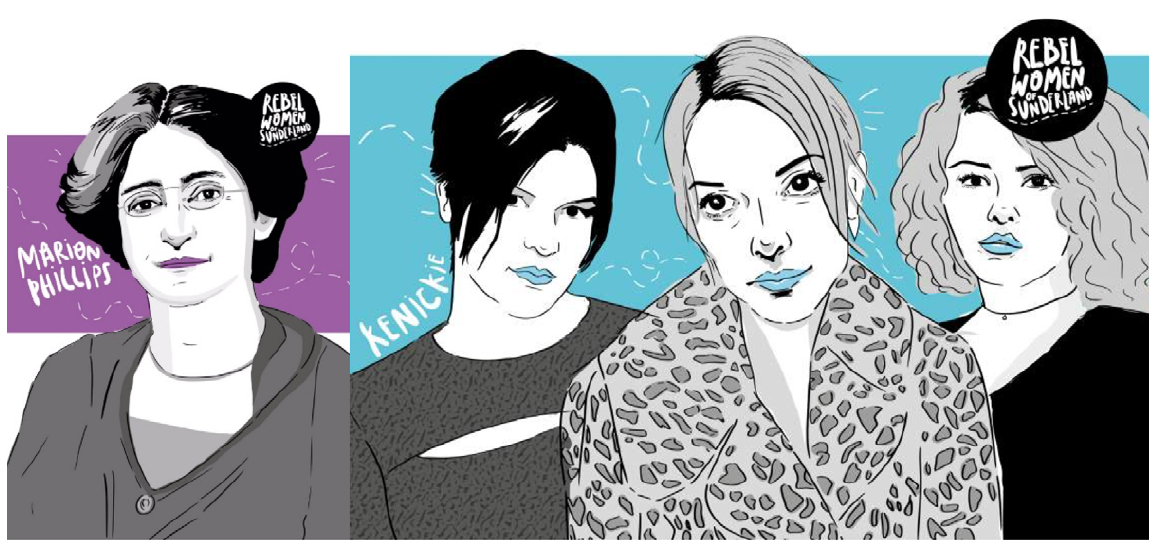
Marion Philips and Kenickie by Kathryn